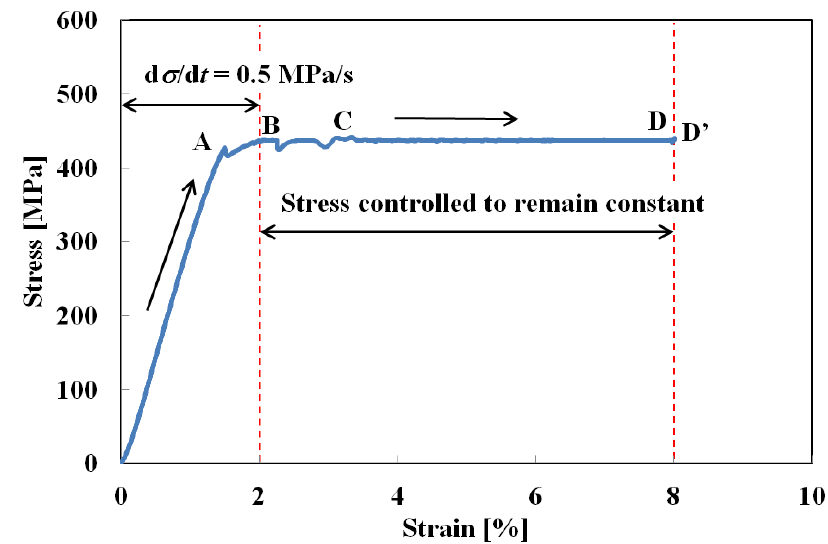
Figure 5. Stress-strain curve under stress rate of d σ /d t = 0.5 MPa/s till strain of 2% followed by stress controlled to remain constant.